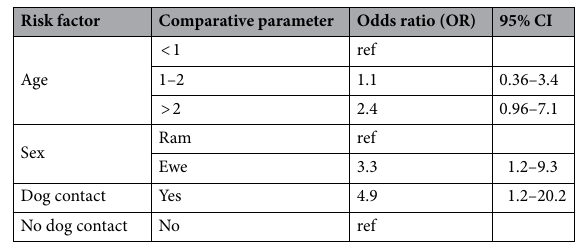
Table 3. Risk factors associated with seroprevalence of N. caninum in sheep according to logistic regression analysis. 95% CI, 95% confidence interval; OR, odds